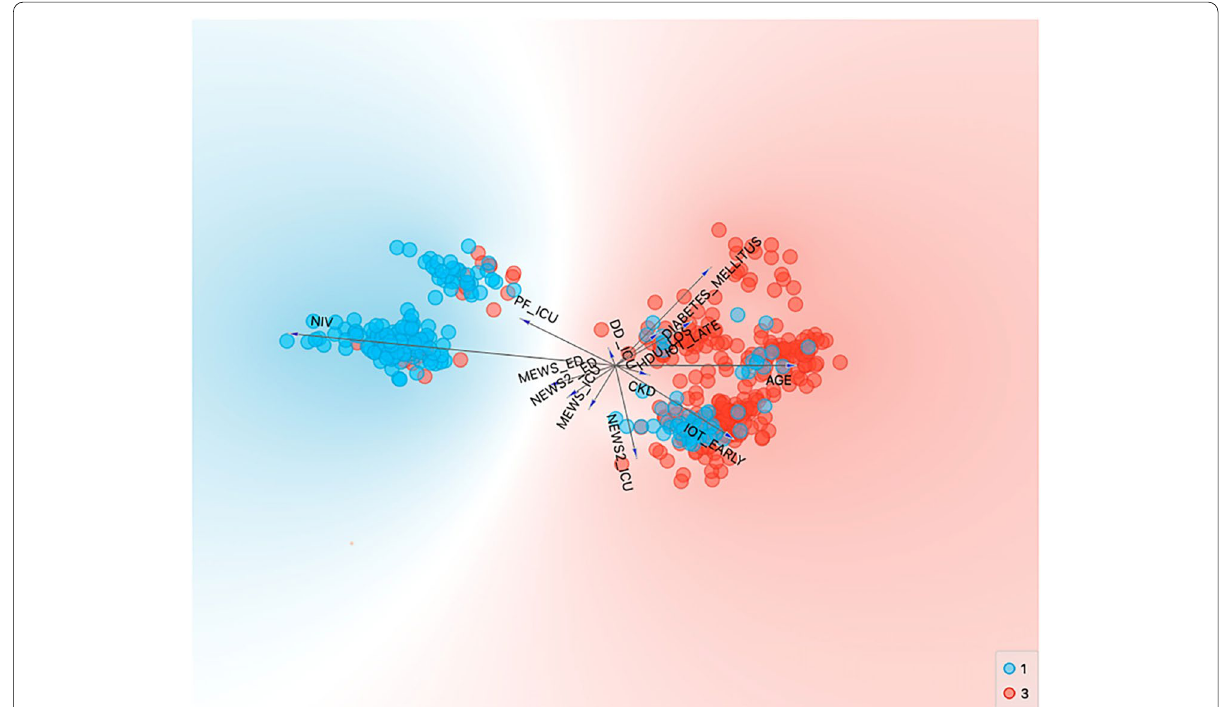
Fig. 2 FreeViz graphic of the scored variables. The blue spots represent the survived patients, the red spots represent the dead patients